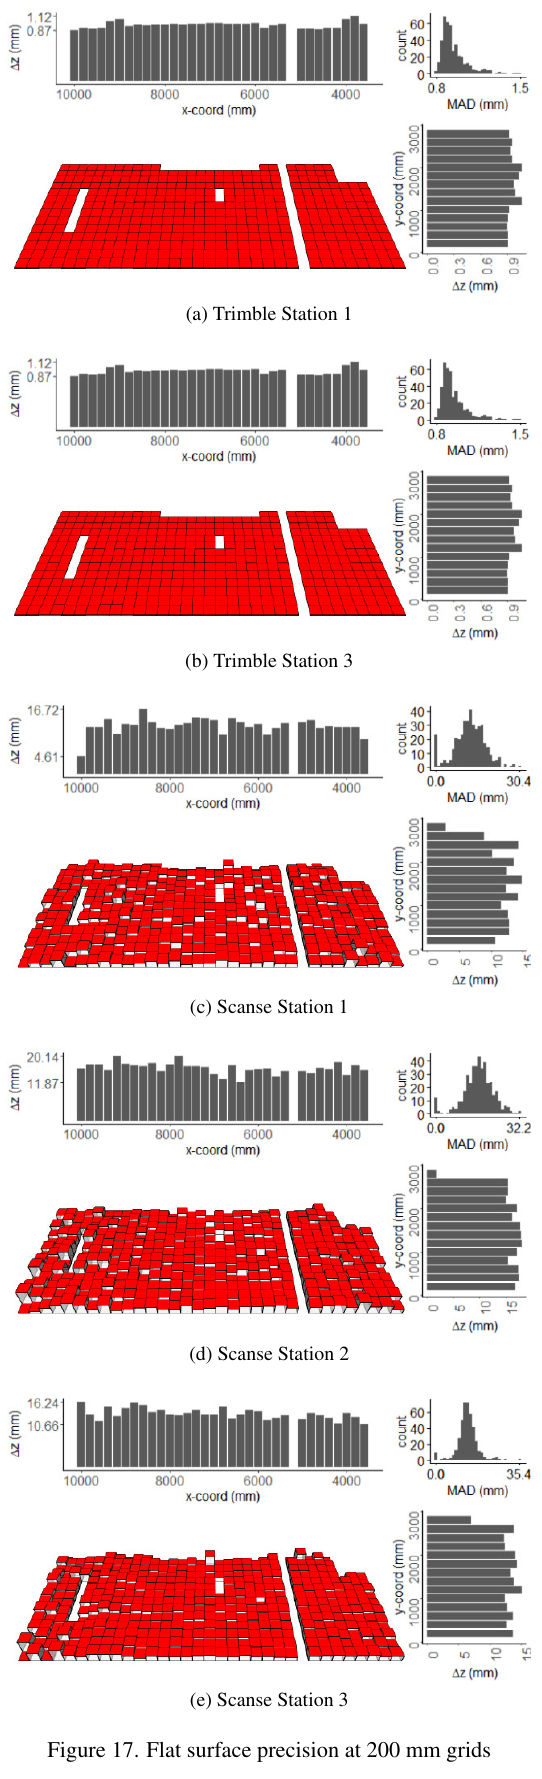
Figure 17. Flat surface precision at 200 mm